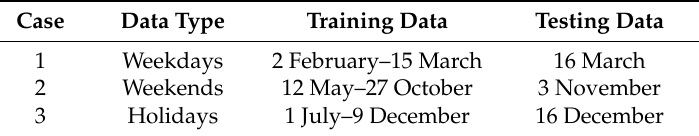
Table 1. The periods of the training and testing load data on TPC in